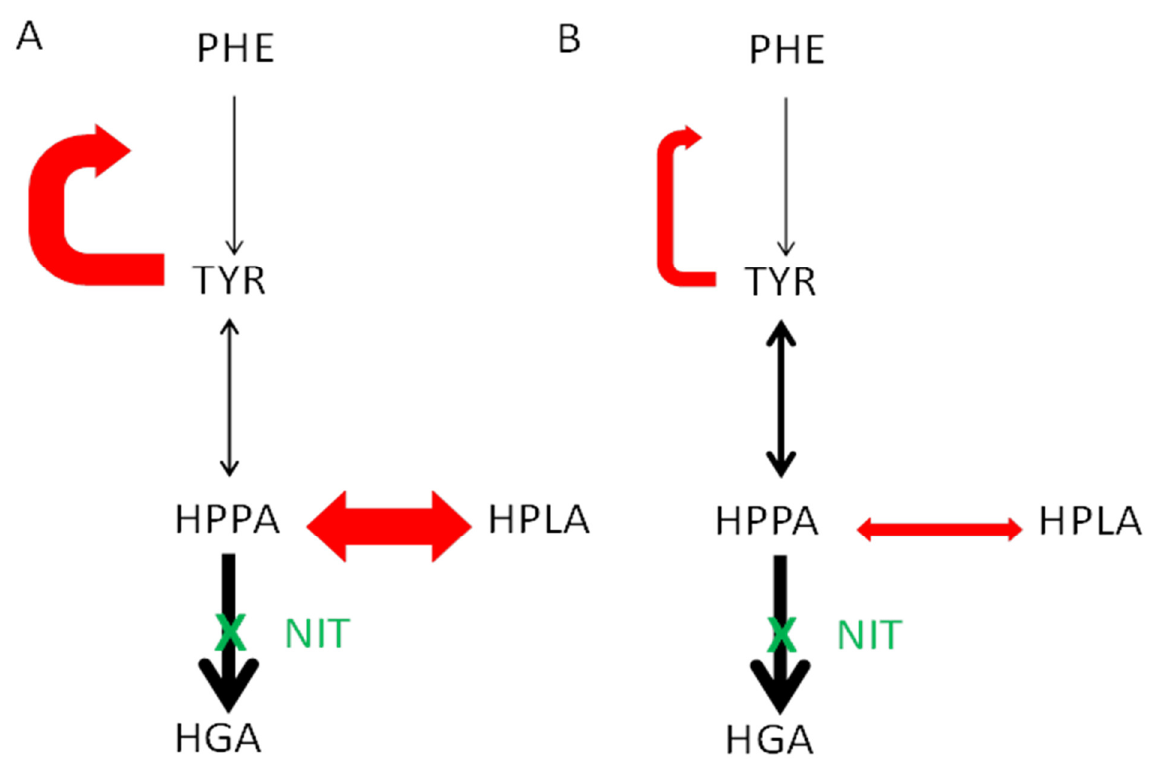
Figure 5. ( A , B ) A cartoon representation of changing relationships between PHE, TYR, HPPA and HPLA during NIT therapy. In A, the figure highlights the state of the pathway in NKP group, showing lesser conversion of PHE to TYR (solid black arrow) inhibited more by TYR (more prominent curved red arrow), and similarly more conversion of HPPA to HPLA (a straight solid red arrow) as well as lesser conversion from HPPA to TYR (a straight black arrow). In B, the figure highlights the state of the pathway in the KP group, showing greater conversion of PHE to TYR (thin solid black arrow) inhibited less by TYR (less prominent curved red arrow), as well as lesser conversion of HPPA to HPLA (a straight solid red arrow) and more conversion from HPPA to TYR (a straight black arrow).